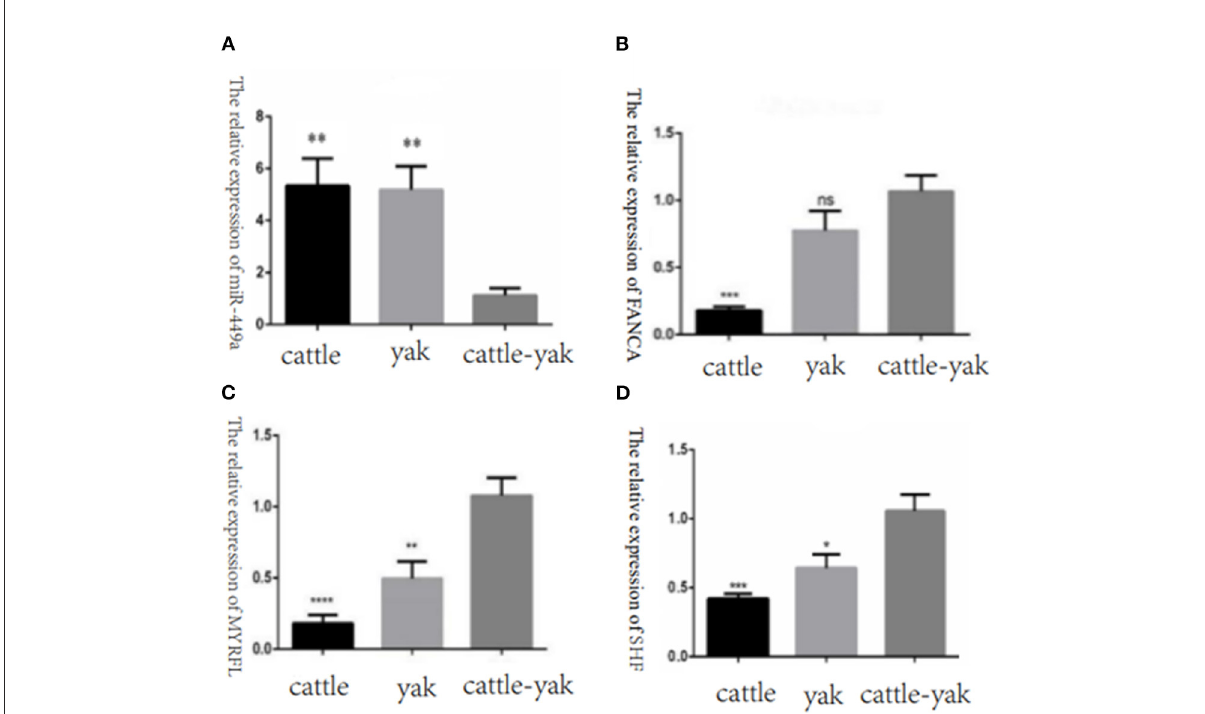
FIGURE11 The relative expression of selected DE miRNAs and target genes in cattle, yak, and cattle-yak groups with qPCR validation. (A) The relative expression of miR-449a in cattle, yak, and cattle-yak. (B) The target gene FANCA relative expression of bta-miR-7 in cattle, yak, and cattle-yak. (C) The target gene MYRFL relative expression of bta-miR-7 in cattle, yak, and cattle-yak. (D) The target gene SHF relative expression of bta-miR-7 in cattle, yak, and cattle-yak.